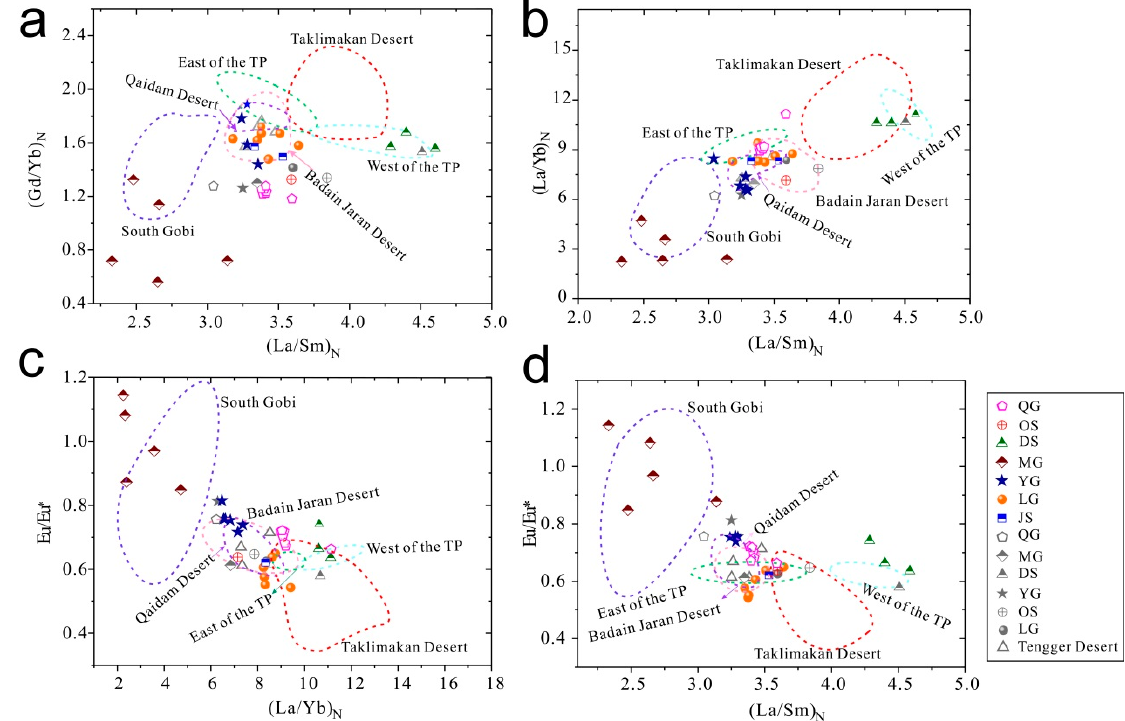
Figure 4. Bivariate diagrams of (La/Sm) N , (La/Yb) N , Eu/Eu* and (Gd/Yb) N ratios of samples from the glaciers and snowpacks, and the comparison with that of central Asian deserts sands, including South Gobi from References [31,32]; Taklimakan Desert finer fraction from [33,34]; Badain Jaran Desert finer fraction from [3,34]; Qaidam Basin and Tengger Desert from [34]; Eastern and western TP from [34,35]. Color icons and gray icons refer to snow dust/cryoconite samples and local dust samples, respectively.( a ) (La/Sm )N versus (Gd/Yb) N ; ( b ) (La/Sm) N versus (La/Yb) N ; ( c ) (La/Yb) N versus Eu/Eu*; ( d ) (La/Sm) N versus Eu/Eu*.